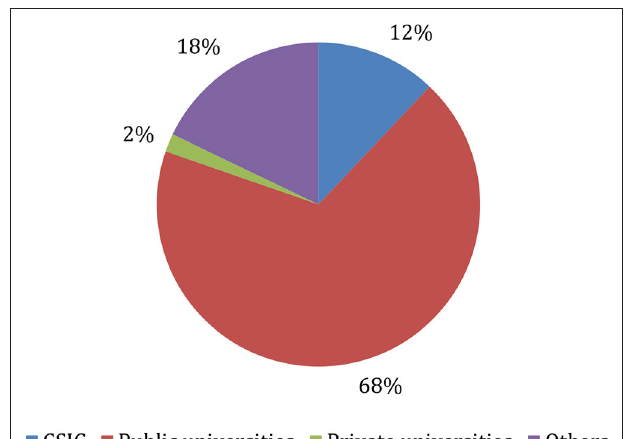
FIGURE 1 | Most cited publications by institution in the period 2005–2014. Percentage.